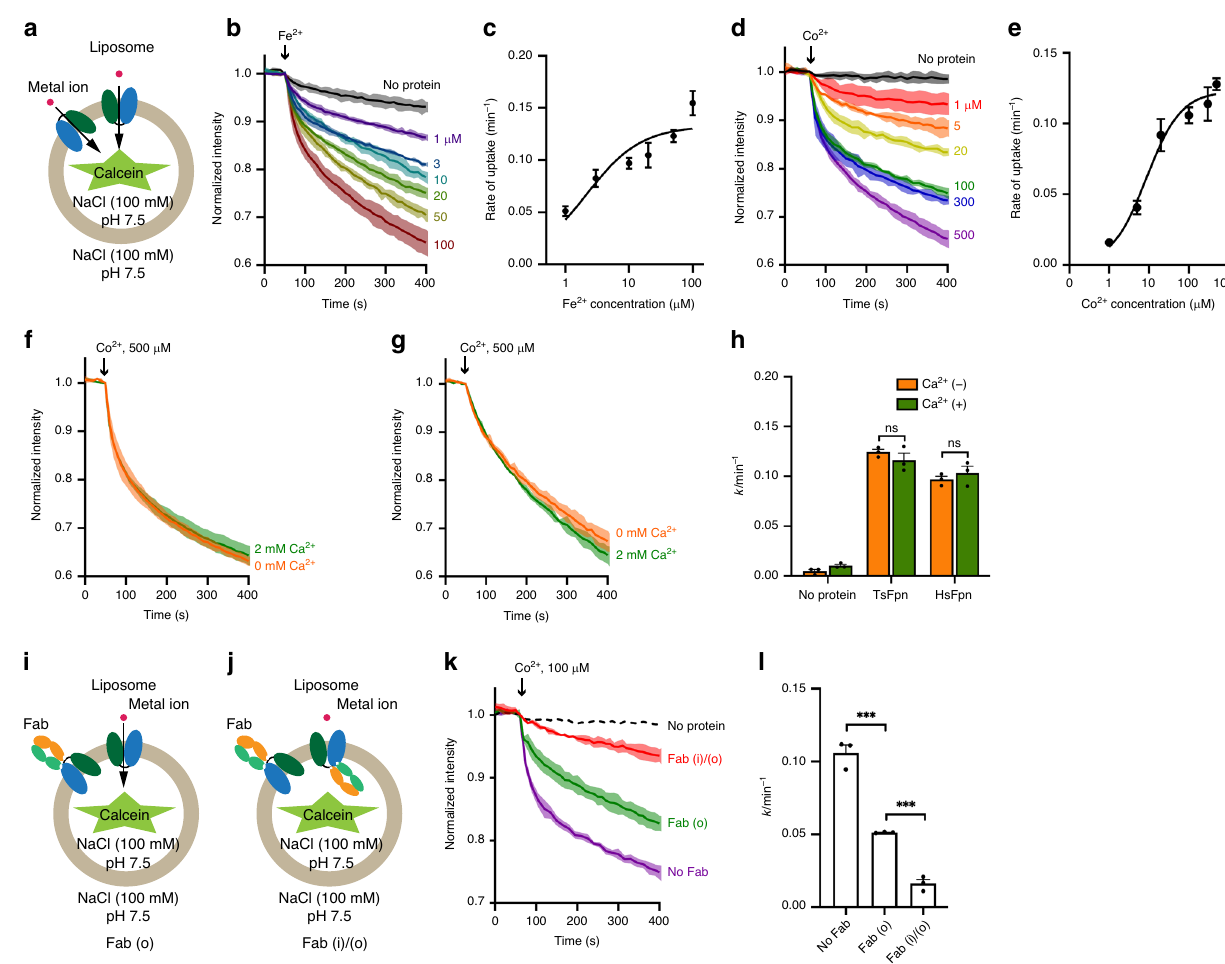
Fig. 1 Function of puri fi ed TsFpn. a Schematic view of a TsFpn-containing proteoliposome with a membrane impermeable calcein dye enclosed. Metal ions (Fe 2 + or Co 2 + , red spheres) are added to the external side and uptake of the metal ions quenches the fl uorescence. Two orientations of TsFpn are shown. b Quench of calcein fl uorescence in the presence of indicated concentrations of external Fe 2 + for liposomes with TsFpn (colored traces) and without TsFpn (black trace, 100 µ M Fe 2 + ). c The initial rate of fl uorescence quench versus concentrations of Fe 2 + . The solid curve is data fi t to a Michaelis – Menten equation. d Quench of calcein fl uorescence in the presence of indicated concentrations of external Co 2 + for liposomes with TsFpn (colored traces) and without TsFpn (black trace, 500 µ M Co 2 + ). e The initial rate of fl uorescence quench versus concentrations of Co 2 + . The solid curve is data fi t to a Michaelis – Menten equation. f – h Co 2 + transport in the presence and absence of 2 mM Ca 2 + by TsFpn ( f ) or human Fpn ( g ). Initial rate constants of uptake in TsFpn and HsFpn plotted as bar graphs ( h ). Two-way ANOVA: within each group, no signi fi cant difference (TsFpn: p = 0.54; HsFpn: p = 0.70). i , j Schematic view of orientation-speci fi c binding of Fab to TsFpn in proteoliposomes when Fab is added to the outside ( i ) or to both sides ( j ) of proteoliposomes. k Co 2 + transport in the absence of Fab (purple trace), in the presence of Fab on the outside (green trace) and on both sides (red trace). l Initial rate constants of transport for traces shown in k . Two-tailed Student ’ s t test: *** p < 0.001. Throughout this article, all time-dependent fl uorescence traces are shown as solid lines with a shade in which the solid line represents the mean value of at least three independent experiments and the width of the shade represents the standard deviation; For all bar graphs, a scatter plot is overlaid on each bar and the height is the mean of at least three measurements and the error bar is the standard error of the mean